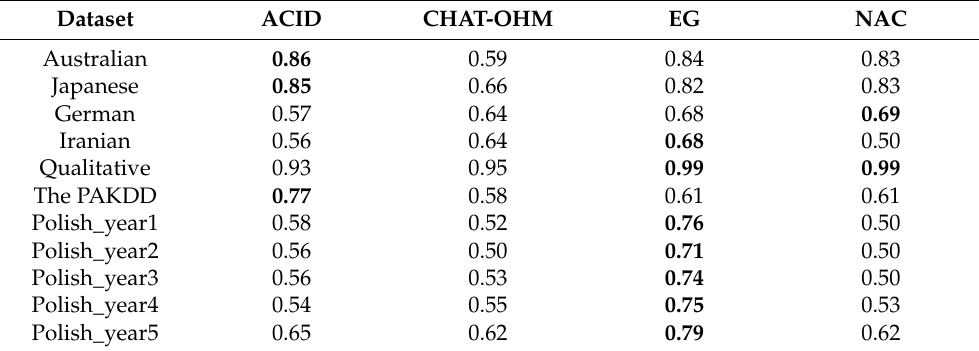
Table 5. Area under the ROC curve of the compared classifiers. The best results are indicated in